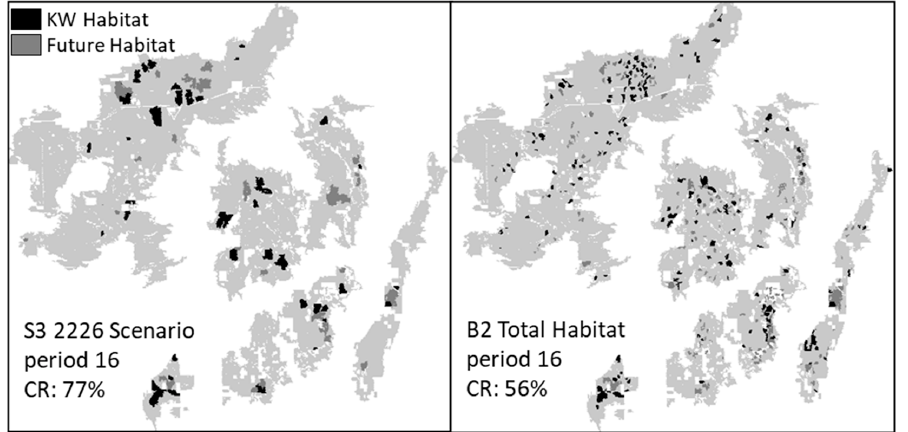
Figure 10. Period 16 core area efficiency ratios for S3 2226 scenario (77%) and B2 Total Habitat bench- mark (56%) . benchmark